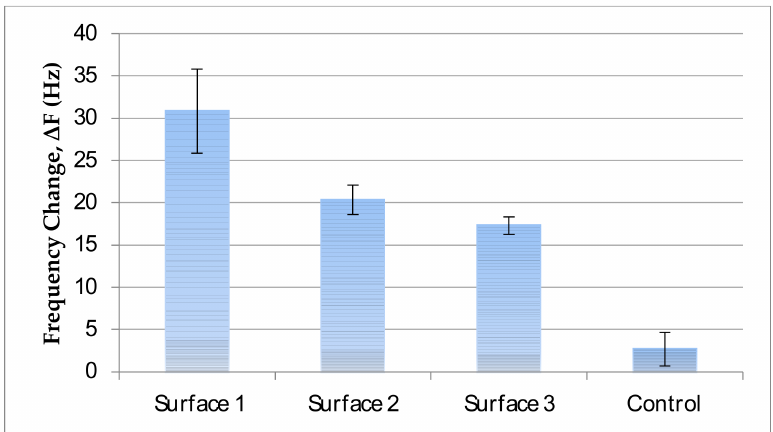
Figure 2. Evaluation of different OTA-immobilized surfaces for their antibody binding capacities. In control bar, BSA was sent to the surface and non-specific adsorption of the surface was measured. Error bars represent standard